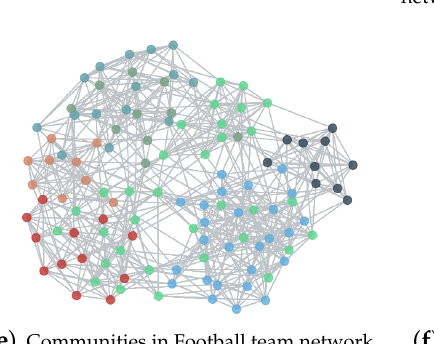
( c ) Communities in the Enron email network. ( d ) Top-five influencers in the folded Enron email network.